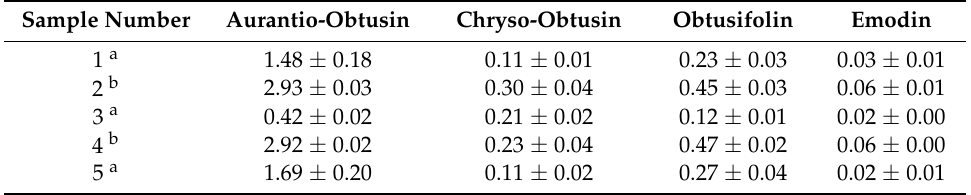
Table 3. Contents (mg · g − 1 ) (mean ± SD) of four compounds in five batches of Cassiae Semen samples by VS-MAPD method.